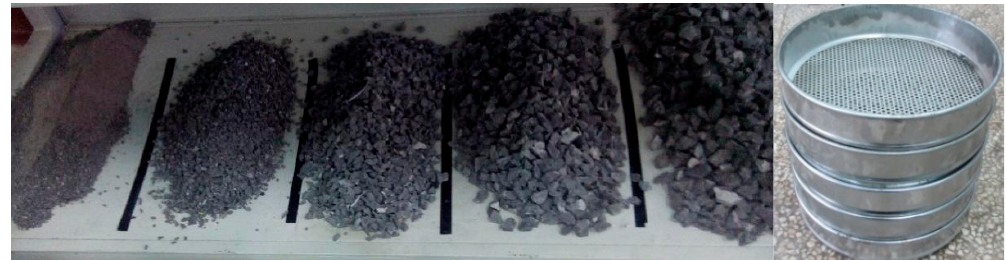
Figure 1. Different particle sizes of gangue and a grading sifter.